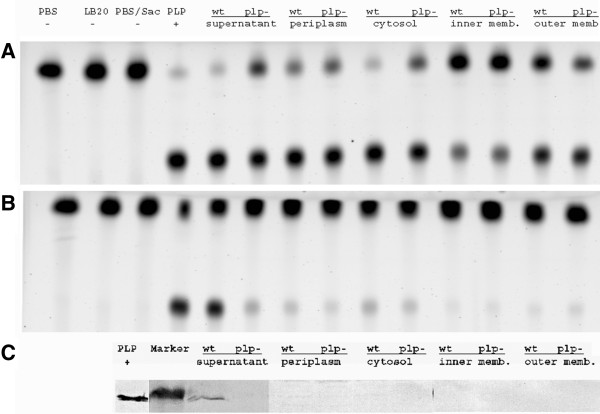
The phospholipase activity assays detected by TLC of various cell fractions prepared from wild type (wt) strain M93sm and plp mutant strain S262 (plp-) were performed at 37°C (A) and 64°C (B). PBS buffer, LB20, and PBS buffer + 1% sarcosylate were served as negative controls. The refolded rPlp protein (PLP +) served as positive control. The top spots on each chromatogram are the BPC substrate and the bottom spots are the BLPC reaction product. The proteins from the same cell fractionation preparations were analyzed by SDS-PAGE and Western blot analysis (C) as described in the Methods. The refolded rPlp protein was served as positive control.